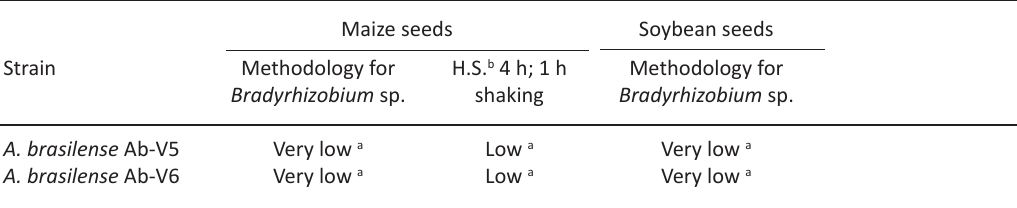
Table 1. Cellular recovery and cell counting a of Azospirillum brasilense from inoculated maize and soybean seeds. Recovery in saline solution with Tween